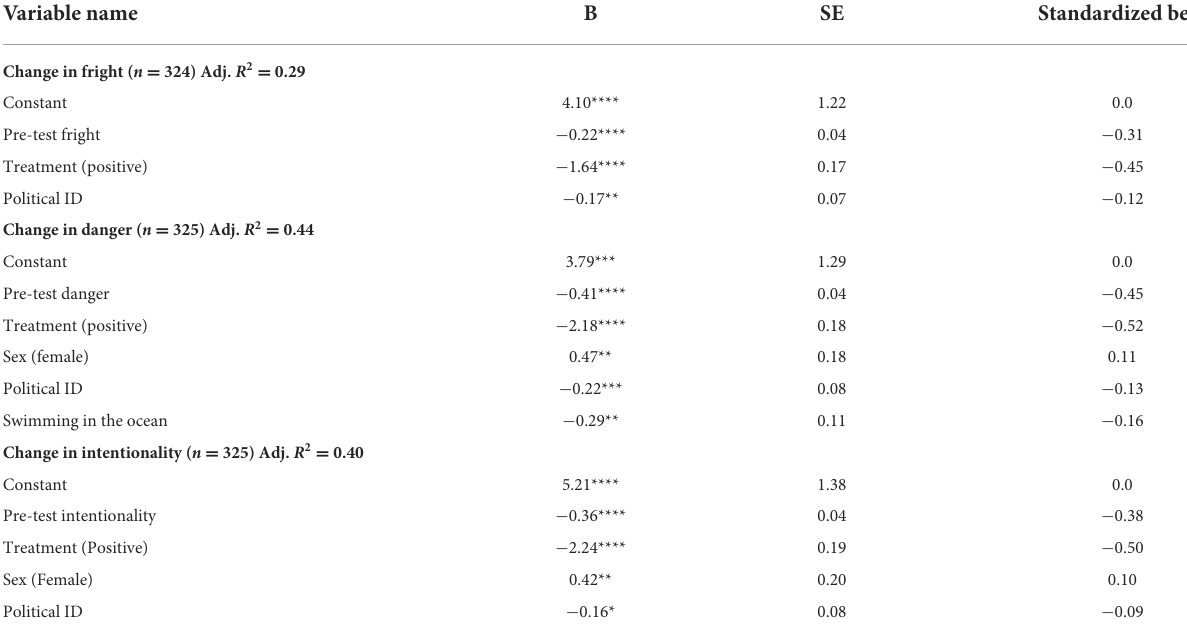
TABLE 3 Model parameters for three ordinary least squares regression models predicting change in perception of fright, danger, and shark bite intentionality. Variable name